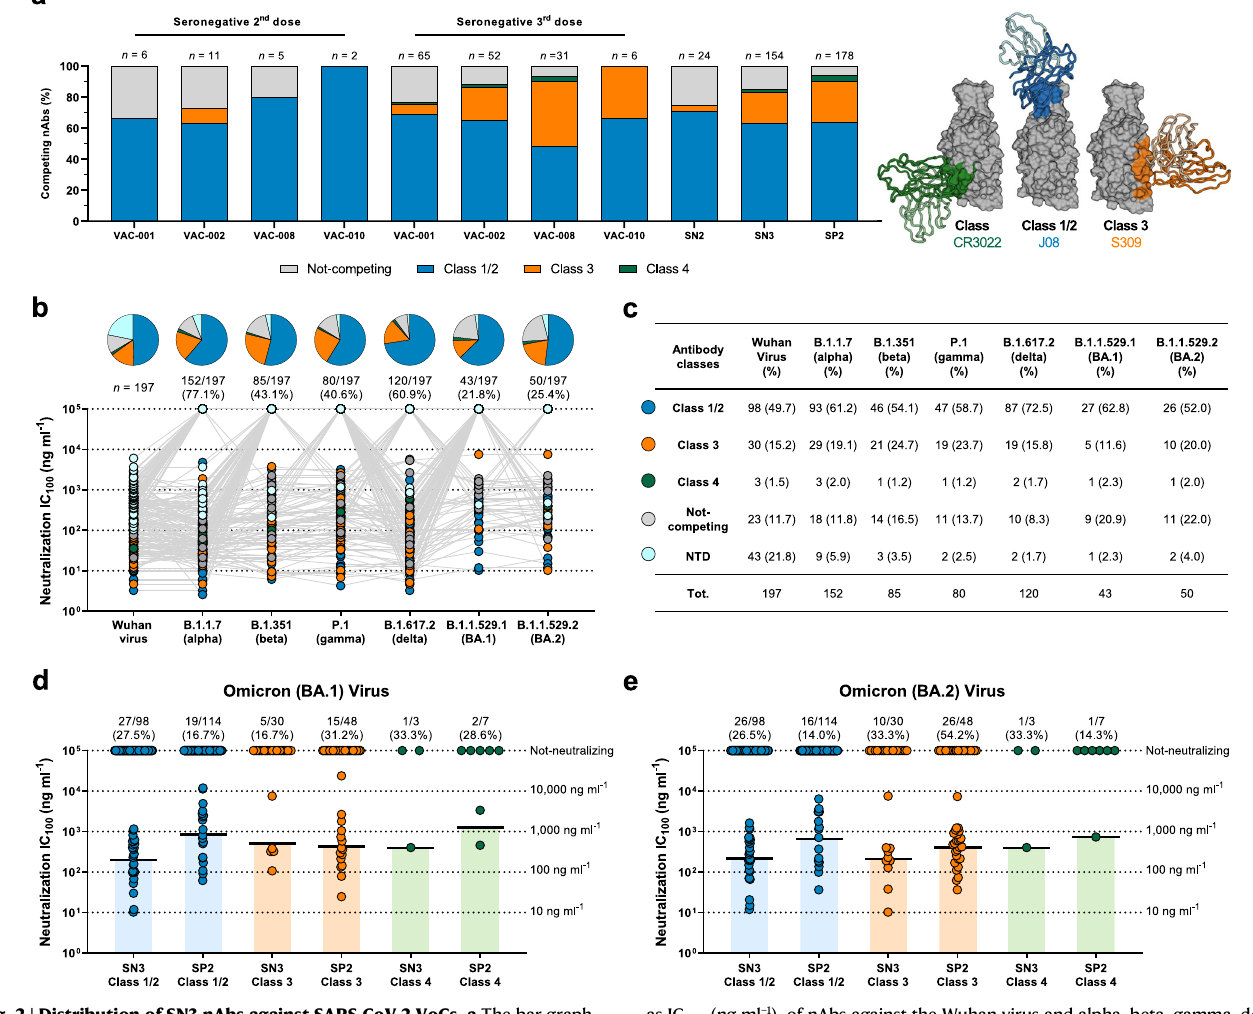
as IC 100 (ng ml − 1 ), of nAbs against the Wuhan virus and alpha, beta, gamma, delta, omicron BA.1, and omicron BA.2 SRS-CoV-2 VoCs observed in the SN3 group. The numberandpercentageofnAbsaredenotedoneachgraph. c thetablesummarizes thenumberandpercentagesofClass1/2,Class3,Class4,not-competing,andNTD- targeting nAbs for each tested variant. d , e Dot charts compare the distribution of nAbs between SN3 and SP2 groups against omicron BA.1 ( d ) and BA.2 ( e ). The number, percentage and GM-IC 100 (black lines and colored bars) of nAbs are denoted on each graph. Source data are provided as a Source Data fi